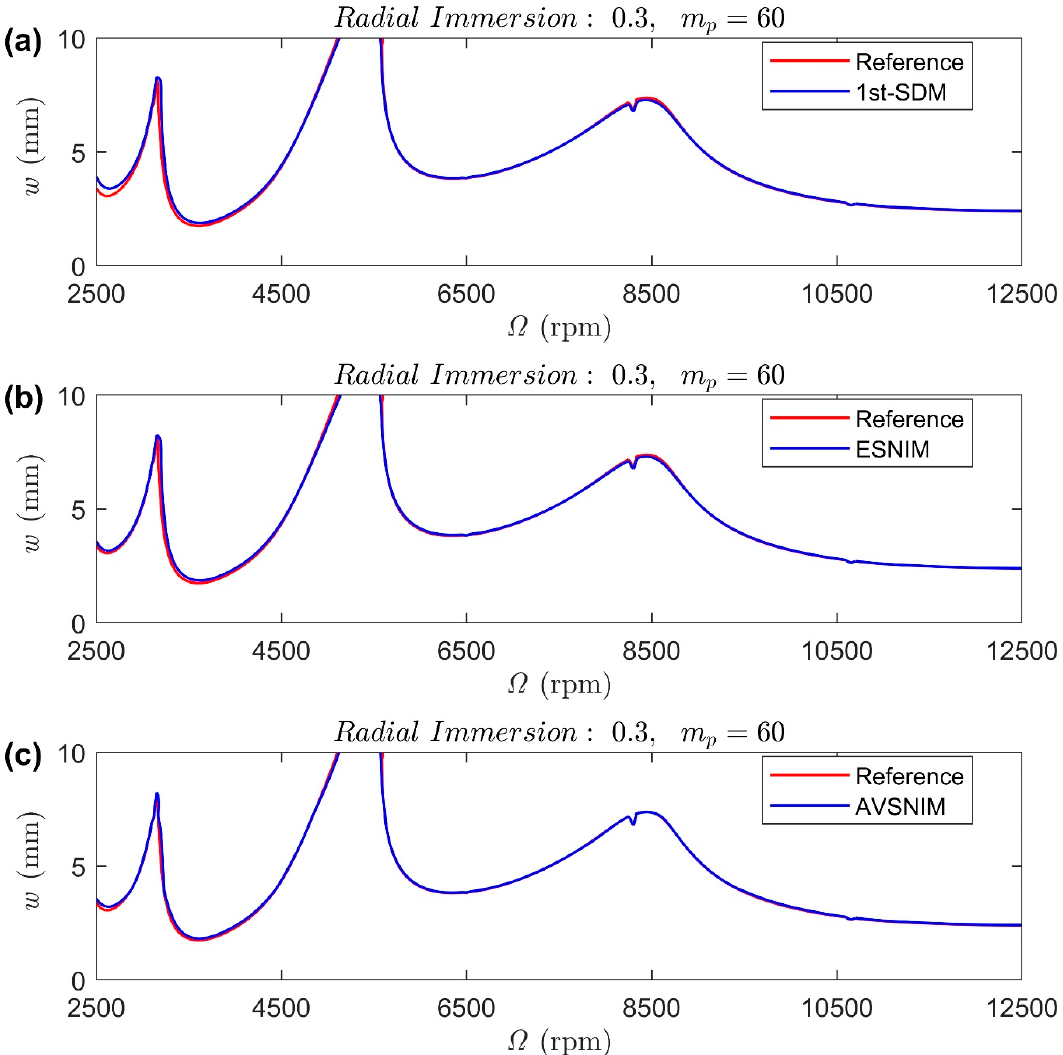
Figure 4. Stability lobes diagram (SLD) of the two-DOF milling model with radial immersion 0.3 and m p = 60, ( a ) SLD obtained by the 1st-SDM; ( b ) SLD obtained by the equal-step numerical integration method (ESNIM); ( c ) SLD obtained by the adaptive variable-step numerical integration method (AVSNIM).